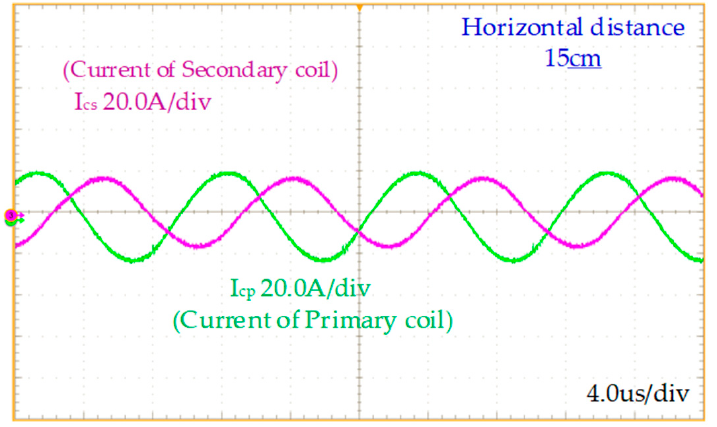
Figure 18. Current waveforms of primary and secondary coils of the 2-coil system (horizontal separation distance is 15 cm).